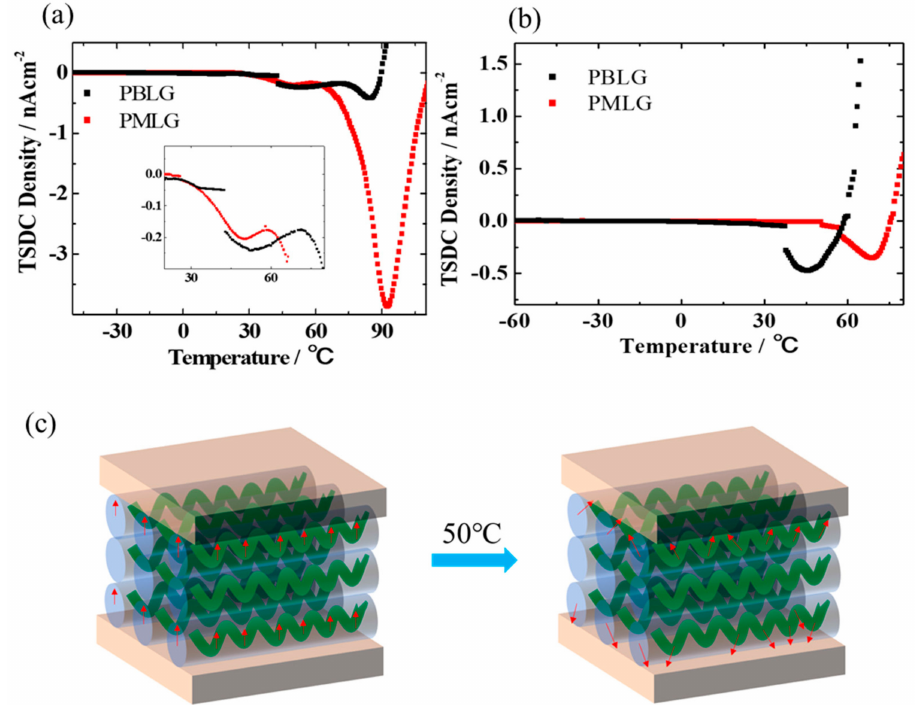
Figure 6. Thermally stimulated depolarization current (TSDC) spectra of ITO / PMLG / Au and ITO / PBLG / Au device at ( a ) 80 ◦ C, ( b ) 50 ◦ C. The insert in ( a ) shows the curves from 20 to 80 ◦ C. ( c ) Illustration of the depolarization process of